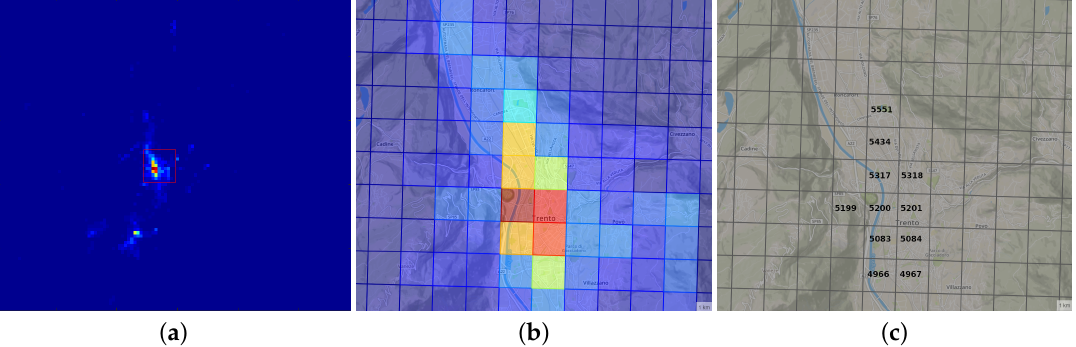
Figure 2. Panel ( a ) shows the classification map resulted after the Euclidean distance classification process over one interval of the data set. Panel ( b ) shows the urban area of Trento which has been zoomed in order to appreciate the difference between urban areas and rural areas within this interval. Panel ( c ) shows the cell identification in the city center of Trento. ( a ) Classification map of the Trento province; ( b ) Projection of the city center of Trento classification; ( c ) Cell identification of the city center of